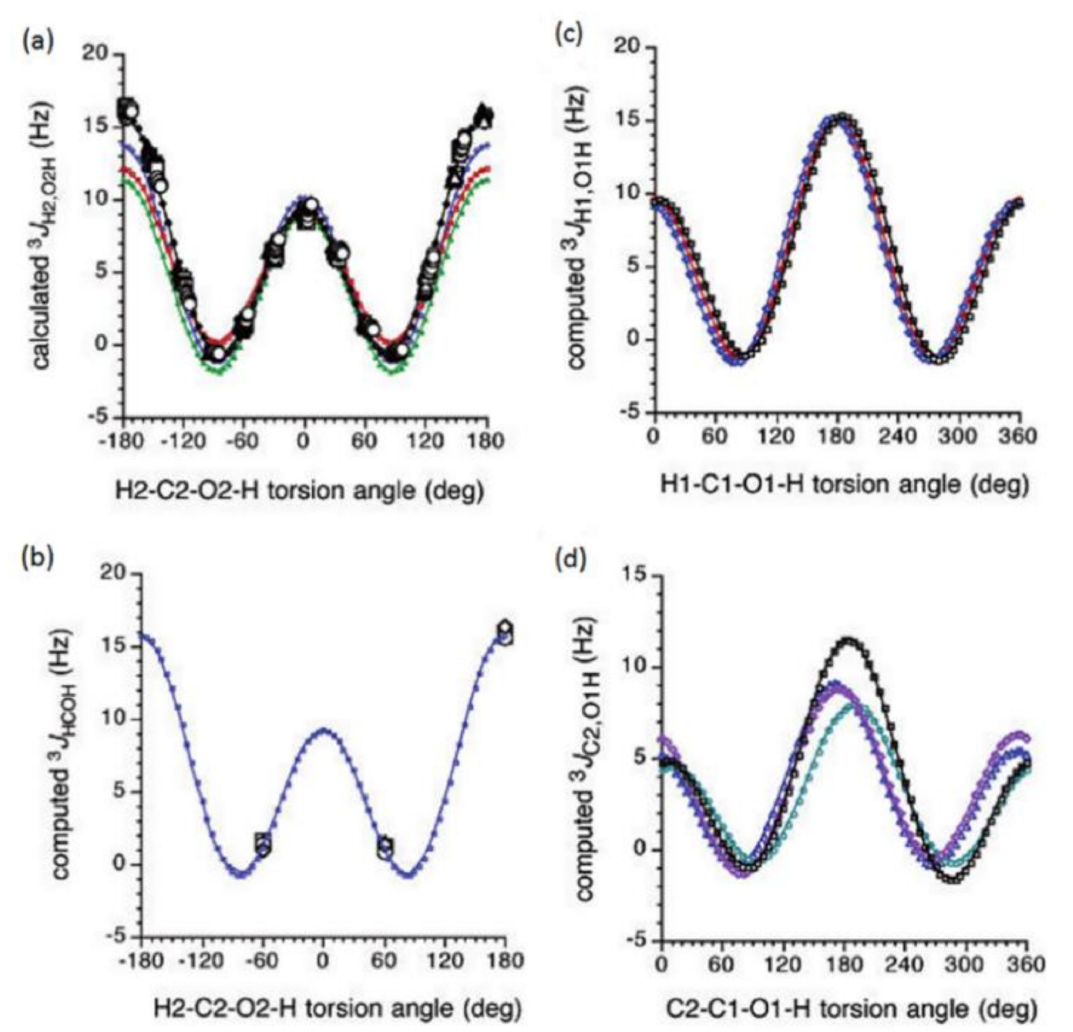
Figure 20. Dihedral angle dependences of vicinal 1 H- 1 H spin-spin coupling constants in model compounds chosen to mimic methyl α - and β -D-aldohexopyranosides: ( a )—Dependence of 3 J H2,O2H on the H 2 -C 2 -O 2 -H torsion angle θ in 15 – 18 ; ( b )—Dependence of 3 J H2,O2H on the H 2 -C 2 -O 2 -H torsion angle in 15 – 18 ; ( c )—Dependence of 3 J H1,O1H on the C 1 -O 1 bond torsion in 19 – 21 (blue triangles) and 20 – 22 (black squares); ( d )—Dependence of 3 J C2,O1H on the C 1 -O 1 torsion angle in 19 (green circles), 20 (blue triangles), 21 (black squares), and 22 (purple diamonds). Reproduced with minor editing privilege from Zhao et al. [124] with the permission of the American Chemical